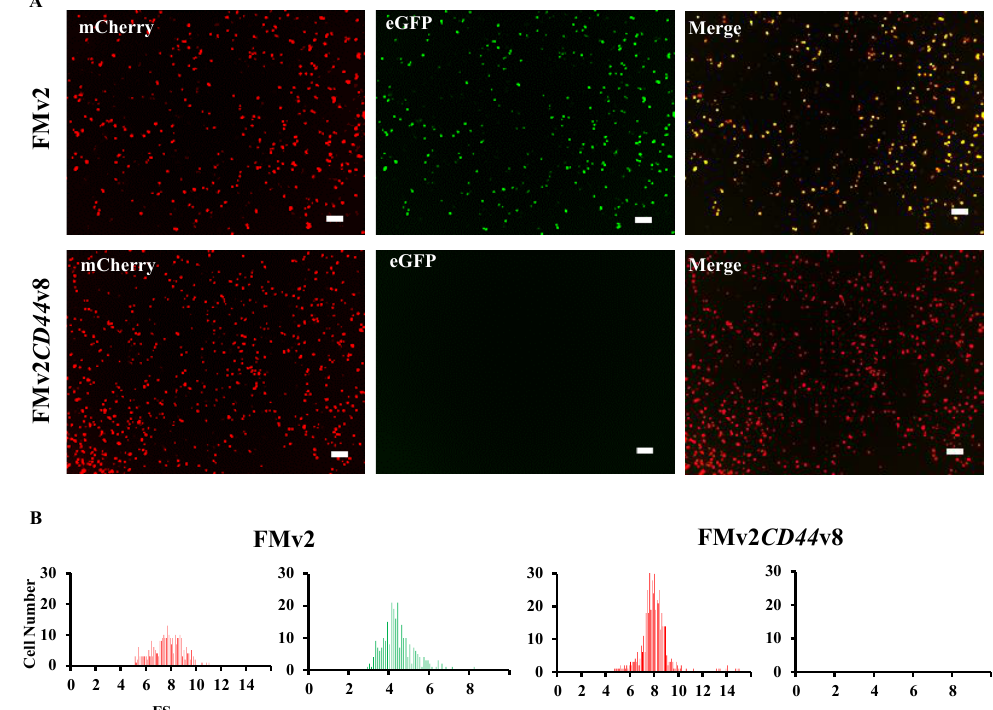
Figure 3. Fluorescence analysis of FMv2 CD44 v8 minigene. ( A ) Fluorescence images of FMv2 CD44 v8 and FMv2 transfected HeLa cells are shown. Red signal was obtained (mCherry) but no green signal (eGFP) was obtained from FMv2 CD44 v8 (bottom), whilst both red and green signals were visualized from FMv2 (top). Yellow signal was detected in the merged image in FMv2 but not in FMv2 CD44 v8 (merge). Scale bars: 100 µ m. ( B ) Histograms representing FS are shown. In FMv2 CD44 v8 transfected cells, no cells were green-positive, only red-positive cells were identified (right). In contrast, cells with red- and green-positive signals were identified in FMv2 cells